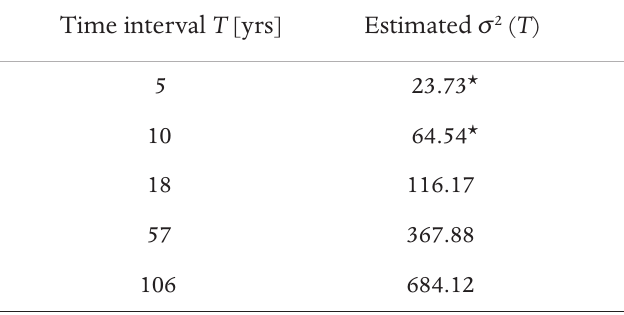
Table 4. Estimated variance of the numbers of observed earthquakes for the different time intervals. *The variance was estimated directly from the catalog. The others values were computed using Equation